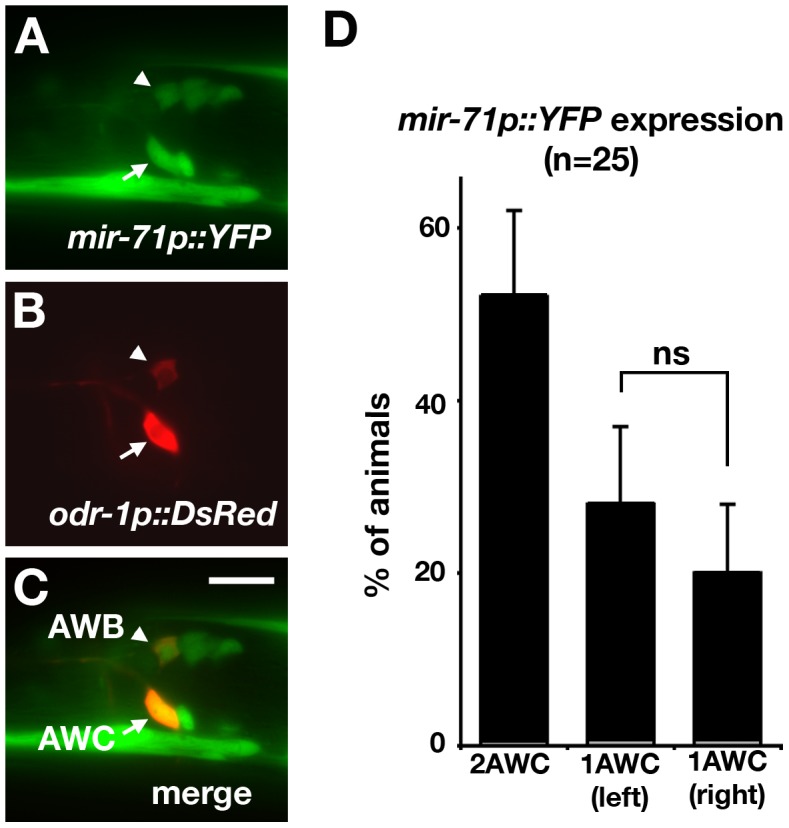

mir-71 is expressed in AWC.(A, B) Images of a first stage larva expressing the transgenes mir-71p::YFP (A) and odr-1p::DsRed, a marker for AWB and AWC neurons (B). (C) Merged image showing co-expression of YFP and DsRed in AWC and AWB neurons. (D) Quantification of the number of AWC neurons with visible expression of the mir-71p::YFP reporter gene at the first larval stage. Z-test was used to calculate statistical significance. Error bar represents the standard error of proportion. ns, not significant. Arrowhead, AWB cell body; arrow, AWC cell body. Scale bar, 10 µm.